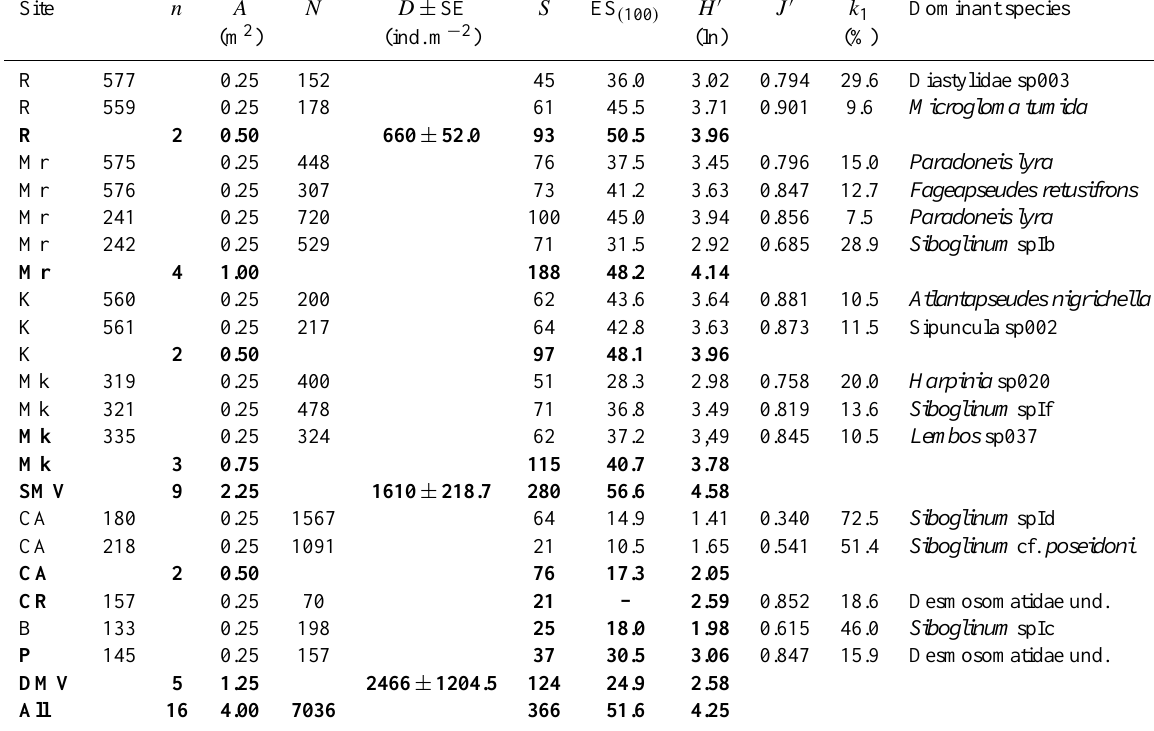
Table 2. Abundance and biodiversity data for macrofaunal samples. n : number of deployments pooled; A : area sampled; N : number of indi- viduals; D : density; SE: standard error; S : species richness; ES ( 100 ) : Hulbert’s expected number of species per 100 individuals; H 0 : Shannon– Wiener diversity (ln base); J 0 : Pielou’s evenness; k 1 : percentage contribution of the first dominant species; R: Reference sites; Mr: Mercator MV; K: Kidd MV; Mk: Men`es MV; CA: Captain Arutyunov MV; CR: Carlos Ribeiro MV; B: Bonjardim MV; P: Porto MV. SMV: